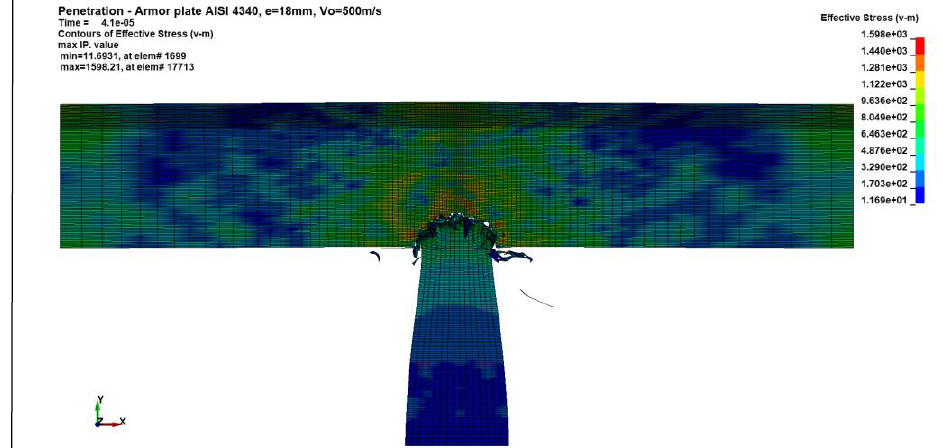
Figure 25 – Von Misses equivalent stress, time of analysis 0.04 ms – Model 4 Рис. 25 – Von Misses эквивалентное напряжение, время анализа 0.04 ms – Модель 4 Слика 25 – Von Misses-ов еквивалентни напон, време анализе 0,04 ms – модел